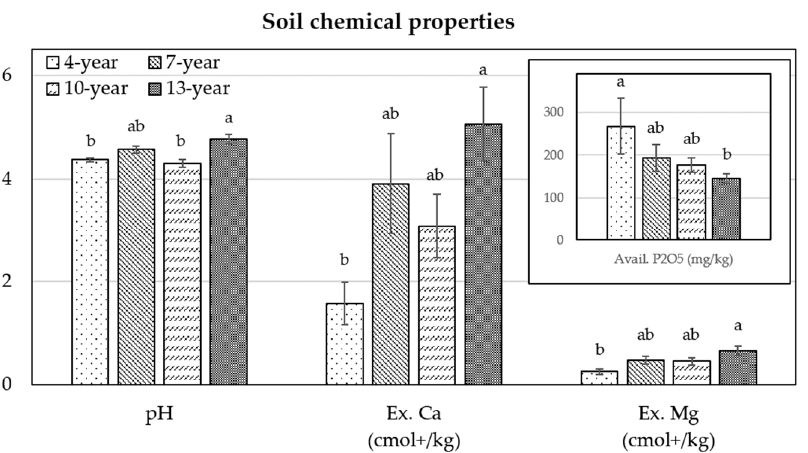
Figure 2. Soil properties of the rhizosphere planted wild-simulate ginseng with different ages. Value in each column with different letters are statistically differences ( p < 0.05) among the treatments according to Tukey’s test (n = 25).